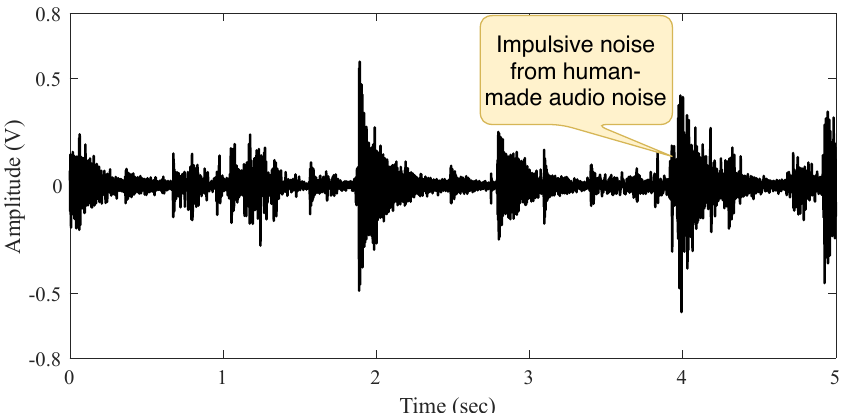
Figure 9. Signal behavior in the outdoor scenario without audio source.